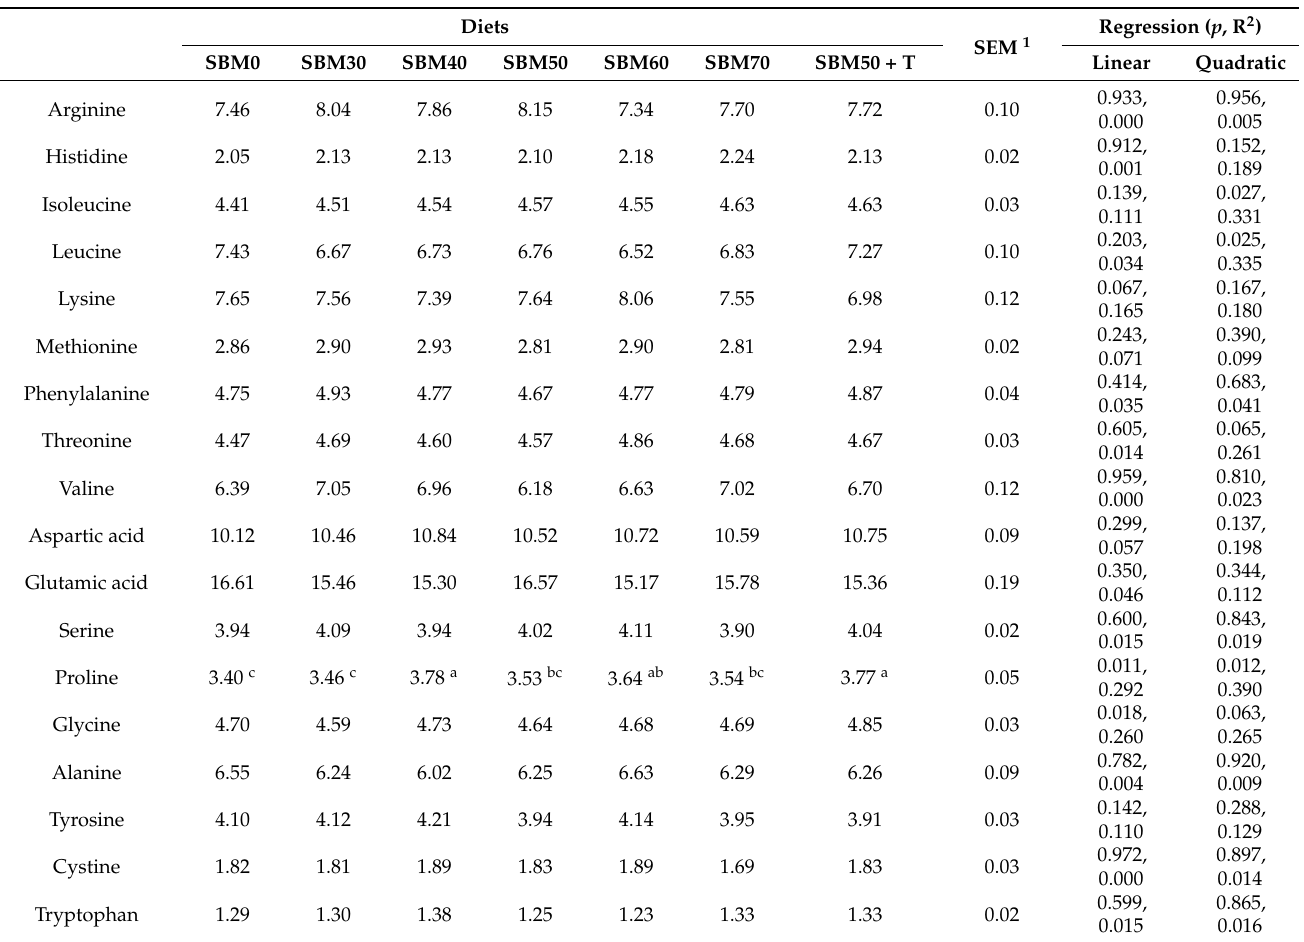
Table 6. Amino acid composition (% of total amino acids) of the whole body of juvenile Oplegnathus punctatus fed diets containing different levels of FM replaced with